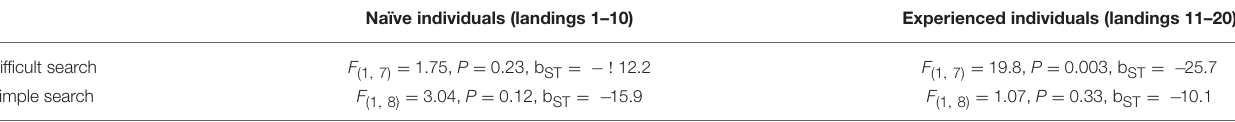
FIGURE 3 | Effects of wing elongation on speed of host-searching. Each data point represents a full-sibling family. Families with more elongate (less circular) wings spent less time initially searching their host environment. Search time is measured as the median time between host-searching TABLE 1 | Associations between thorax mass at emergence and host-finding